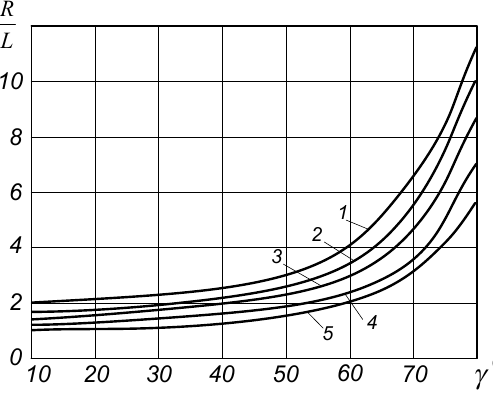
Fig 3. The dependence of the strobe pulse delay on the scanning angle: 1 is 1; 2 is 0; 3 is 0,5; 4 is 0,25; 5 is 0 The law of